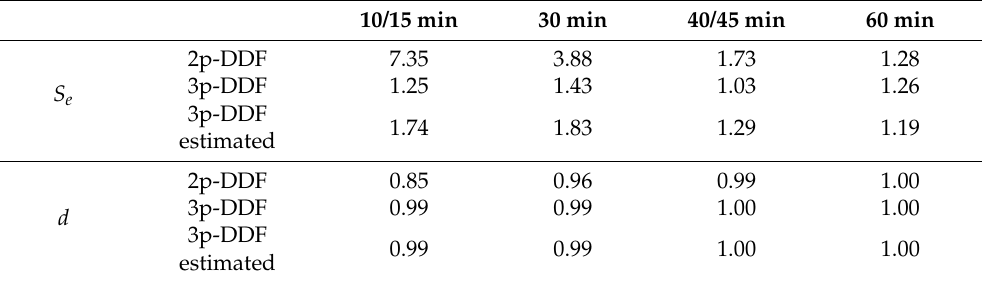
Table 3. Standard error of estimate ( S e ) and index of agreement ( d ) of 2p-DDF, 3p-DDF, and 3p- DDF estimated curves of stations in Sicily and Milan in estimating the rainfall depth from Gumbel